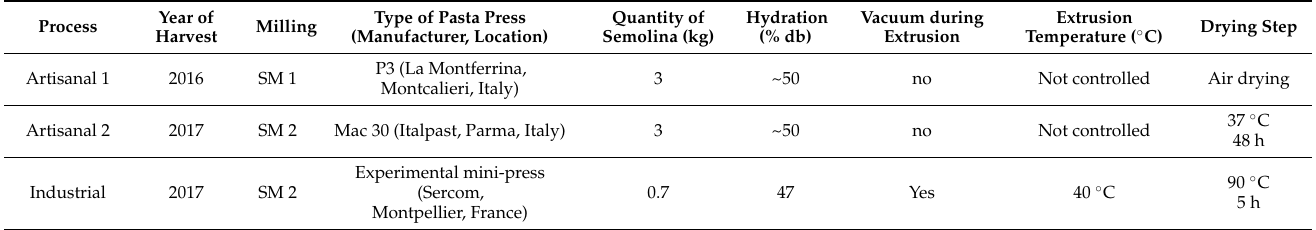
Table 2. Pasta making conditions used in “Artisanal 1”, “Artisanal 2” and, “Industrial” processes.